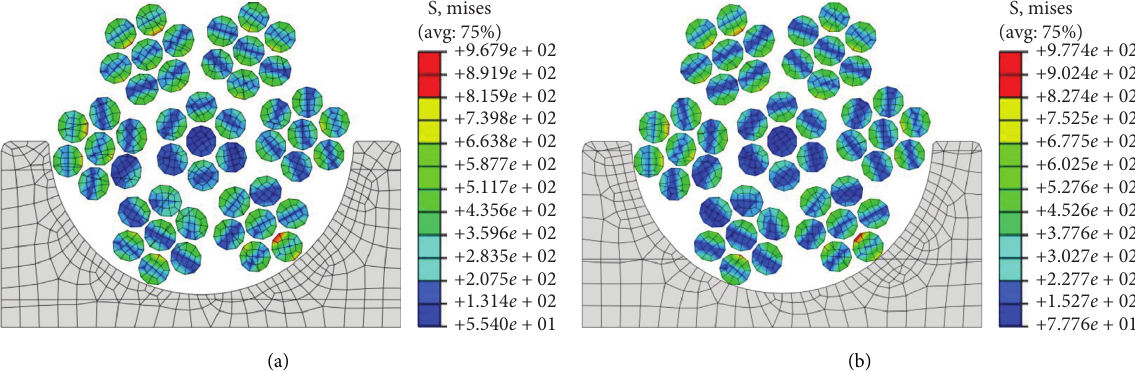
Figure 11: Von Mises stress of the continuous and discontinuous contact model of D-D cross-section. (a) Von Mises stress in the continuous contact model. (b) Von Mises stress in the discontinuous contact model.